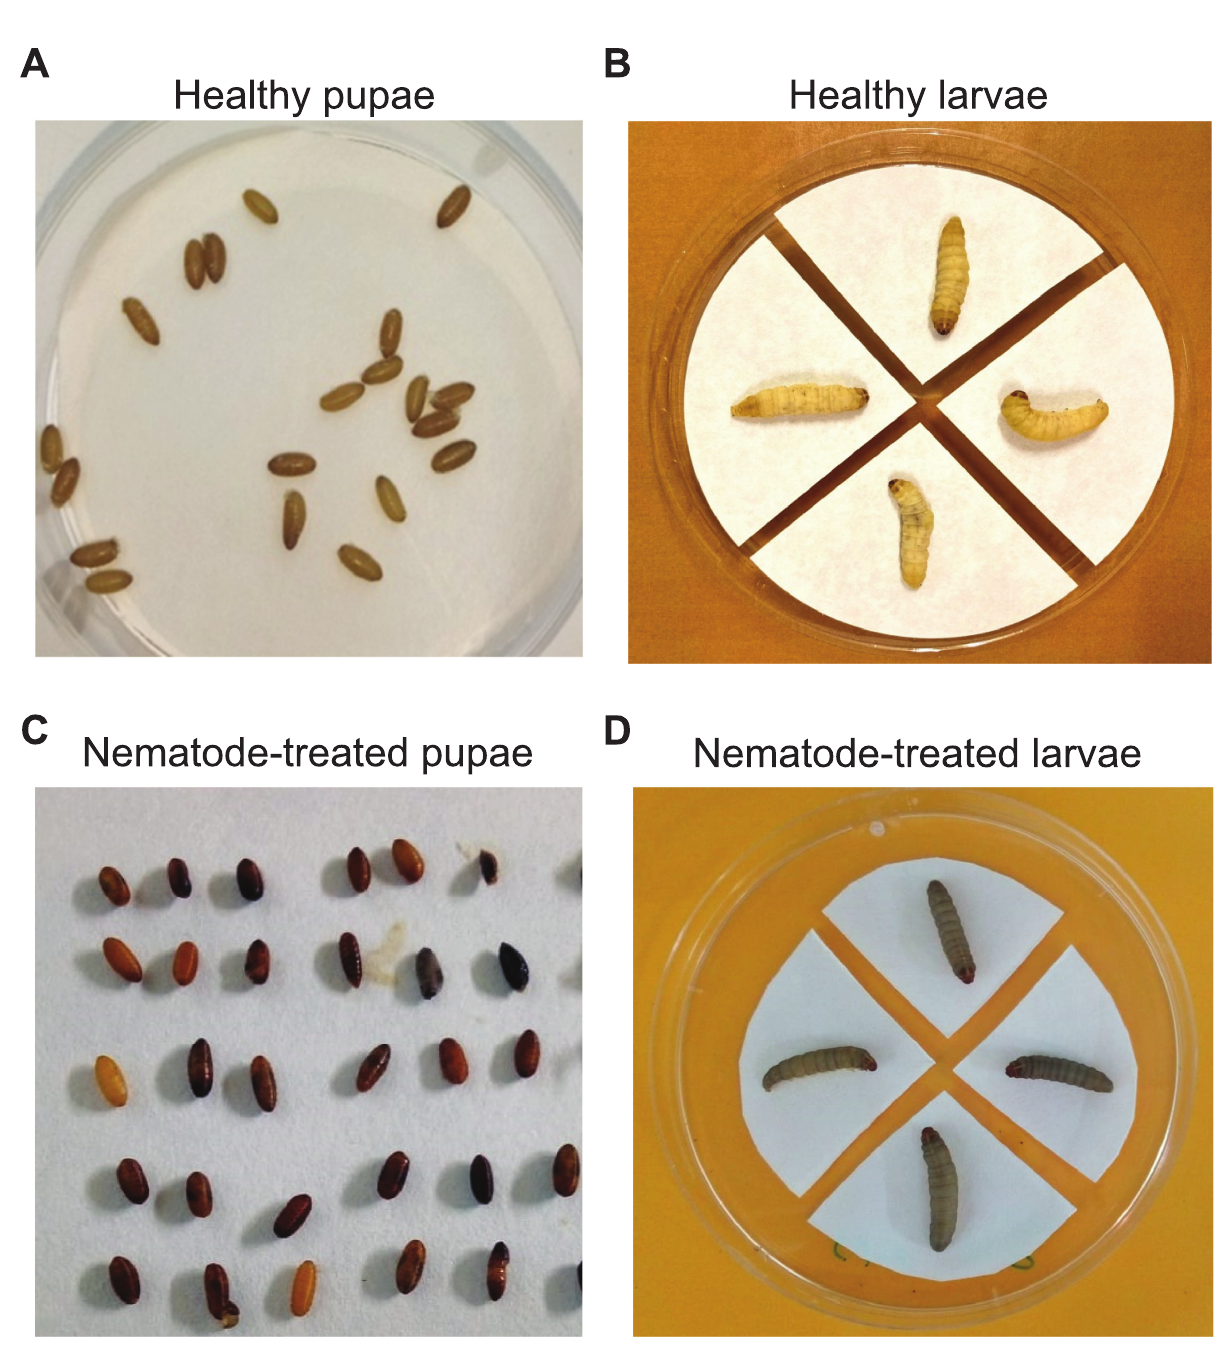
Fig 2. Phenotypic characteristics of healthy insects and of insects exposed to O . tipulae nematodes. (A) Healthy C . capitata pupae. (B) Healthy G . mellonella larvae. (C) C . capitata pupae exposed to O . tipulae nematodes. (D) G . mellonella larvae exposed to O . tipulae nematodes.